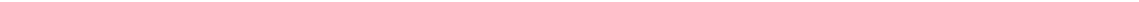
Fig. 3 Crystal structure of antibody H3v-47 Fab in complex with H3N2v HA (A/Minnesota/11/2010) and identi fi cation of the epitope. a Overall structure of the H3v-47 Fab- H3N2v HA complex. One HA/Fab protomer of the trimeric complex is colored with HA1 in yellow, HA2 in orange, Fab heavy chain in green, and Fab light chain in cyan. N-linked glycans are depicted as colored balls representing their atom types (carbon in pink, oxygen in red and nitrogen in blue). The other two protomers are in gray, but the third Fab molecule is hidden behind the HA trimer. b Zoomed-in view of the interaction between H3N2v HA and H3v-47 Fab with color coding as in a . H3v-47 Fab binds to the region spanning the receptor-binding and vestigial esterase sub-domains (shown as a solid surface in yellow and wheat, respectively) mainly using CDRs H2, H3, L1, and L3. The contact regions ascribed to antigenic sites A and E are highlighted in orange or red, respectively. c H3v-47 epitope mapped onto the H3N2v HA surface. The footprint of antibody H3v-47 on the HA shows the central role of antigenic E site residues for H3v-47 binding. The interacting surface contributed by residues from antigenic sites A or E is colored in red or orange, respectively, whereas residues that contribute to the epitope outside of these two antigenic sites, are colored in yellow. d Antibody contact residues (sticks) that interact with the HA with CDRs H2, H3, L1, L3, and FR3 in the light chain. e Speci fi c interactions (H-bonds, salt bridges, hydrophobic interactions, and VDW contacts) between H3v-47 and its footprint residues shown as sticks. The H-bonds and salt bridges are labeled using dash